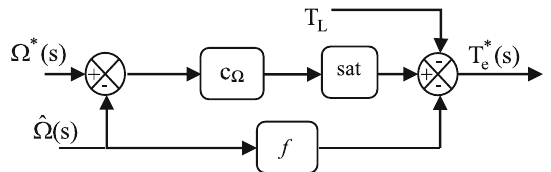
Fig. 4 Speed loop in sliding mode control